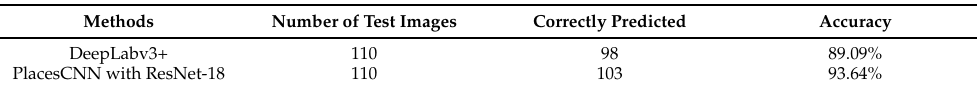
Table 11. Accuracy of DeepLabv3+ and PlacesCNN for test images. "Reprinted with permission from Ref. [23]. 2022,